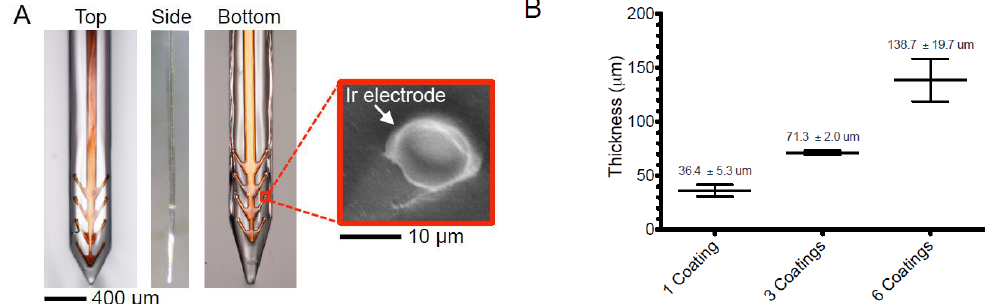
Figure 4. ( A ) Example of flexible polyimide probe coated in silk for temporary stiffening during insertion. Anchor-like protrusions from probe designed with intent to minimize probe micromotion in brain. Opening angle represented by angular spread of probe tip: 60° and 30° opening angles in top and bottom views, respectively. ( B ) Graph describing relationship between number of silk coatings and total device thickness. Reproduced with permission from [90].